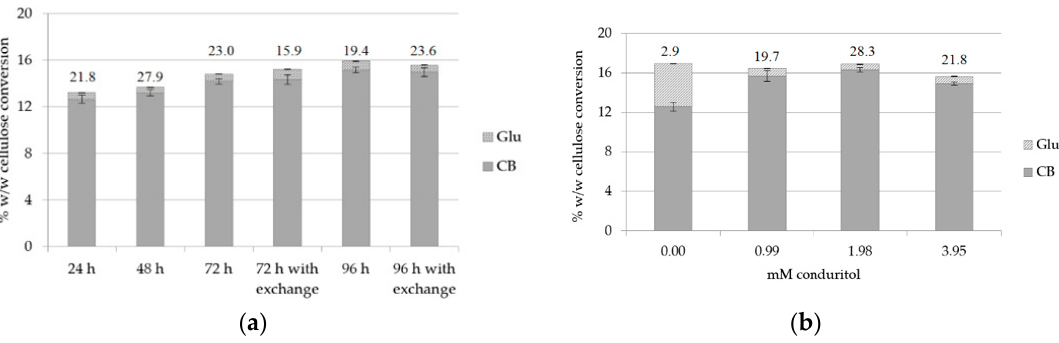
Figure 4. Cellulose conversion (% w/w) to CB and Glu: ( a ) for different hydrolysis time and evaluation of buffer exchange after 72 (buffer exchange at 48 h) and 96 h (buffer exchange at 72 h) of hydrolysis; ( b ) for various concentrations of conduritol-B-epoxide at pH 7.0. The CB:Glu ratio is also described for: ( a ) different hydrolysis time; ( b ) 24 h of reaction. Table 2. Trials with different temperature and incubation time. All experiments have been conducted upon the addition of 1.98 mM conduritol-B-epoxide and a pH 7.0, while buffer exchange was applied at 12 h.